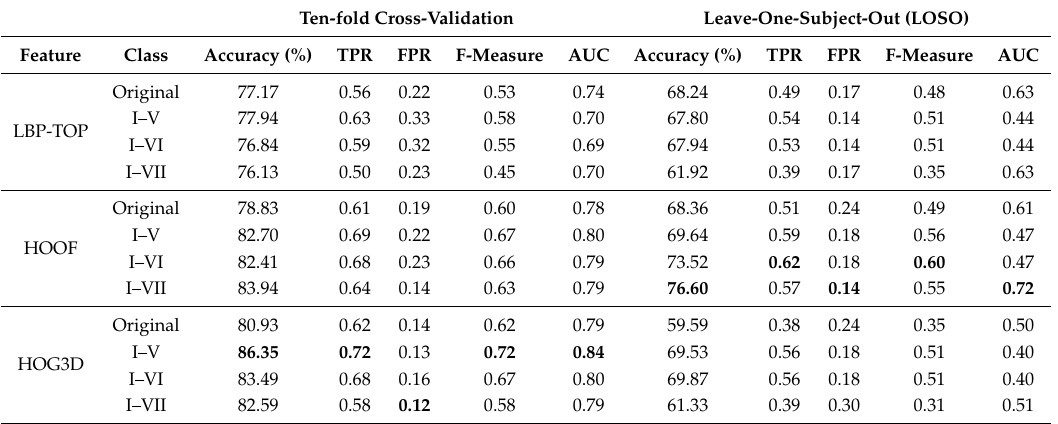
Table 4. Results on the CASME II dataset showing each feature, proposed classes, and the original classes defined in [23] for comparison.